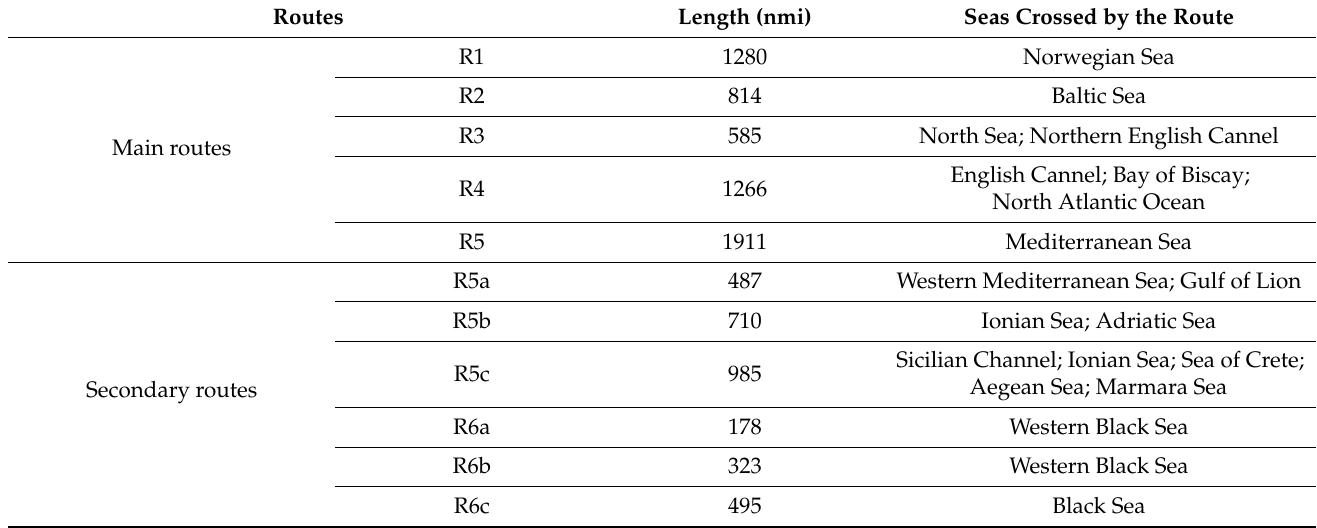
Figure 2. Tracks of the European routes (the main routes are represented with thicker lines, while the secondary routes are marked with thinner lines). Table 1. Characteristics of the European routes.